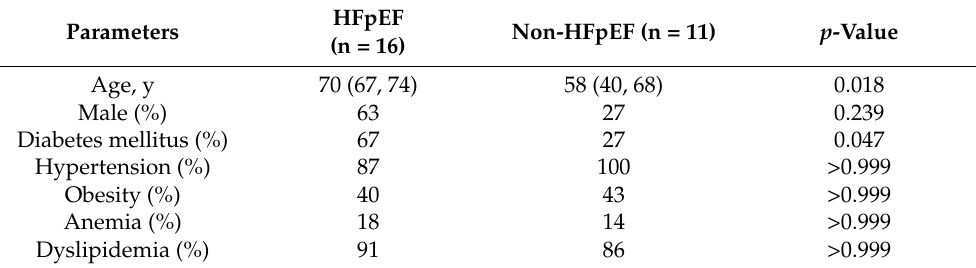
Table 1. Clinical characteristics of patients. Categorical variables are presented by percentages (%), and continuous variables are given by median (Q1,